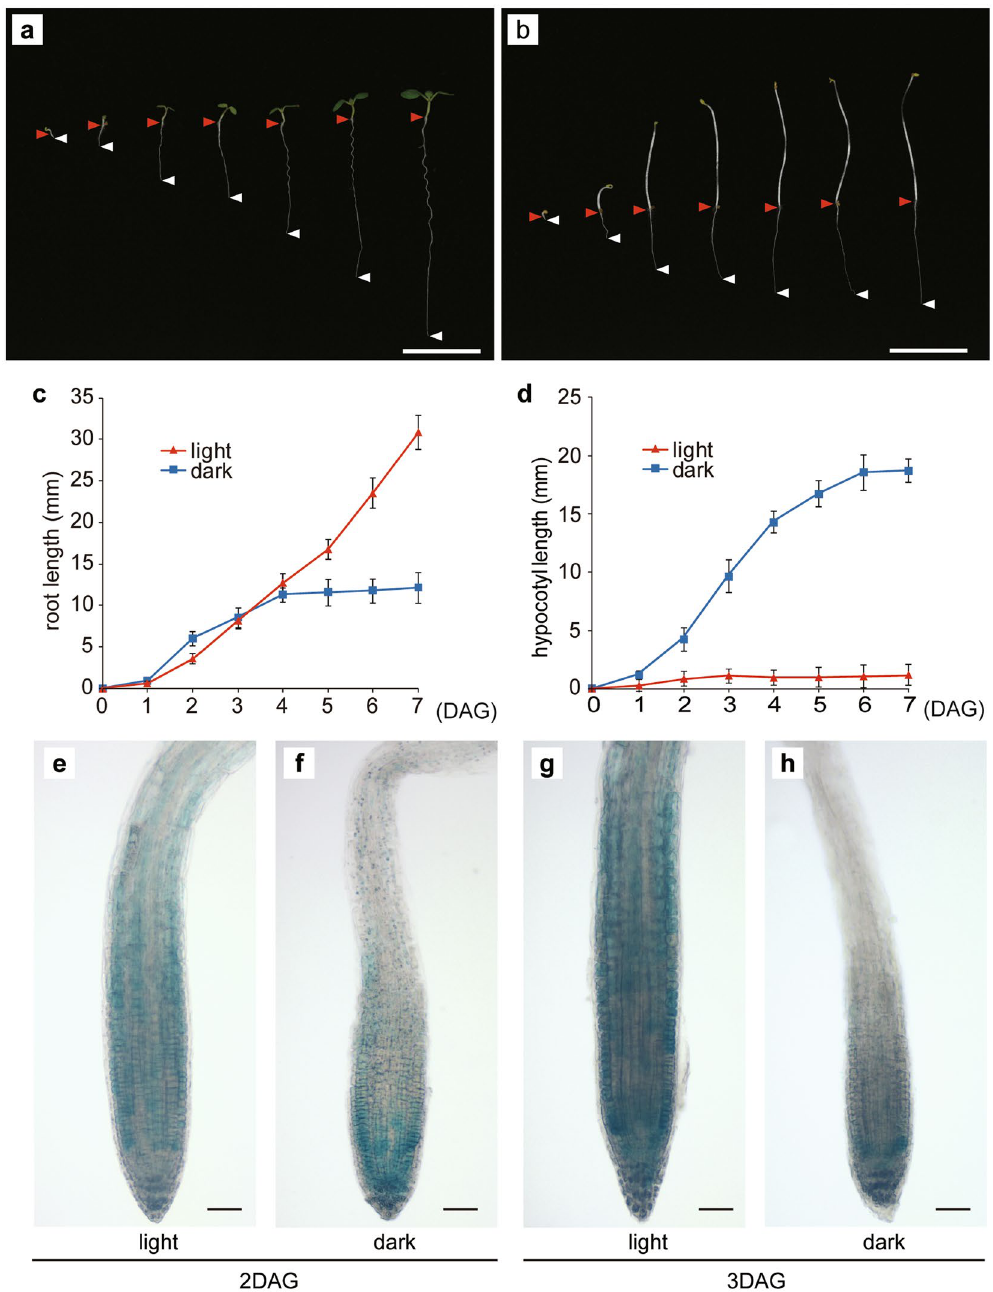
Figure 3. Root and hypocotyl growth and DWF4-GUS expression patterns. Plant growth under light ( a ) and in darkness ( b ) from 1 to 7 days after germination (DAG). Red arrowheads indicate the junctions between the hypocotyl and root, while white arrowheads indicate the root apex positions. Root ( c ) and hypocotyl ( d ) lengths from 1 to 7 DAG [n = 24]. After 3 DAG, the plants grown in darkness exhibited decreased root growth. ( e – h ) DWF4-GUS expression pattern in the root meristem. At 2 DAG, there were no differences in DWF4-GUS signals between the root meristems of plants incubated under light ( e ) or in darkness ( f ). At 3 DAG, the DWF4- GUS signal intensity in the roots incubated in darkness ( h ) started to decrease in the meristematic region and cell elongation zone. Scale bars represent 10 mm ( a , b ) and 50 µ m ( e – h ). Error bars represent standard